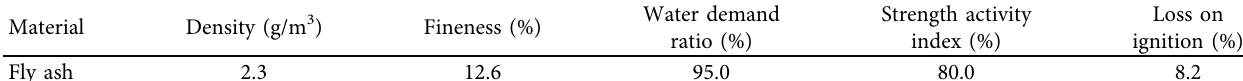
Table 4: Physical properties of